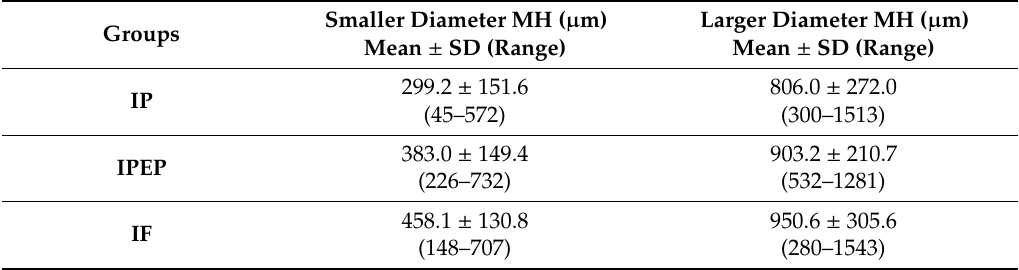
Table 2. Optical Coherence Tomography (OCT) characteristics of full thickness macular hole (FTMH).